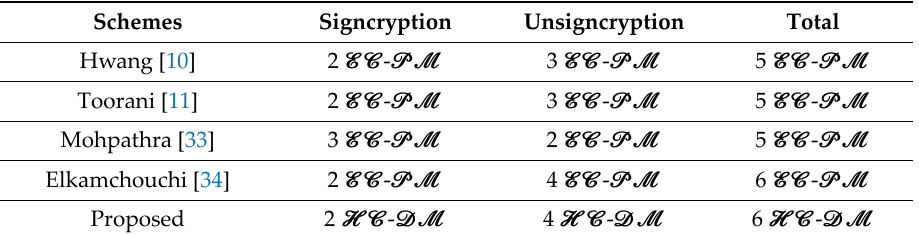
Table 2. Comparison of computational cost in terms of major